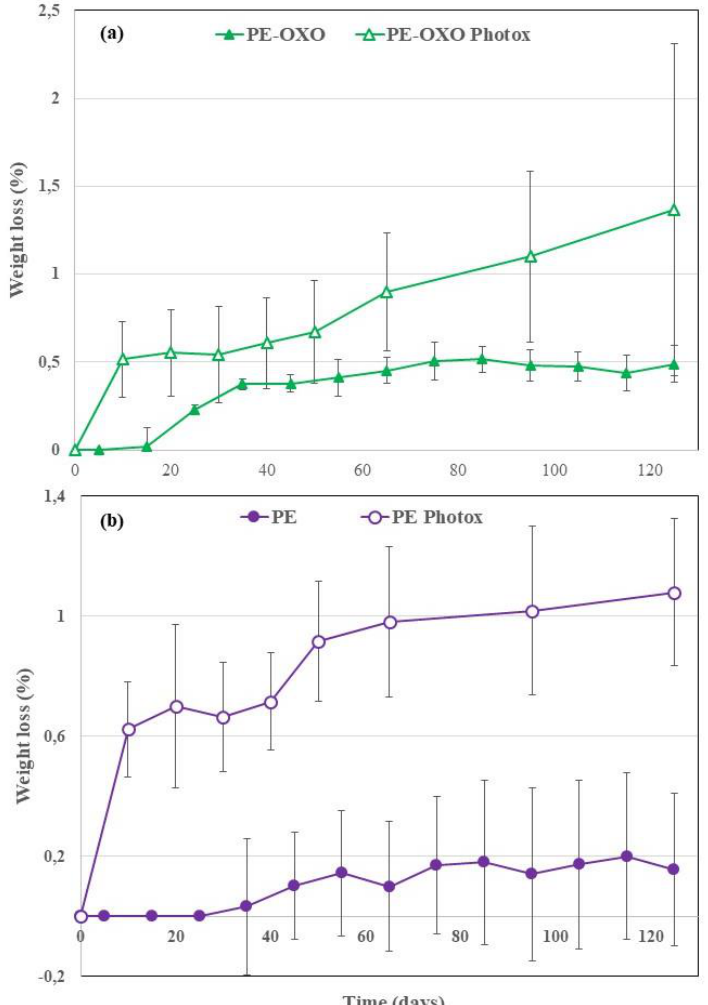
Figure 5. Average weight loss values (%) vs. degradation time for the film samples ( a ) polyethylene (PE)-OXO and ( b ) PE, virgin and photo-oxidized.